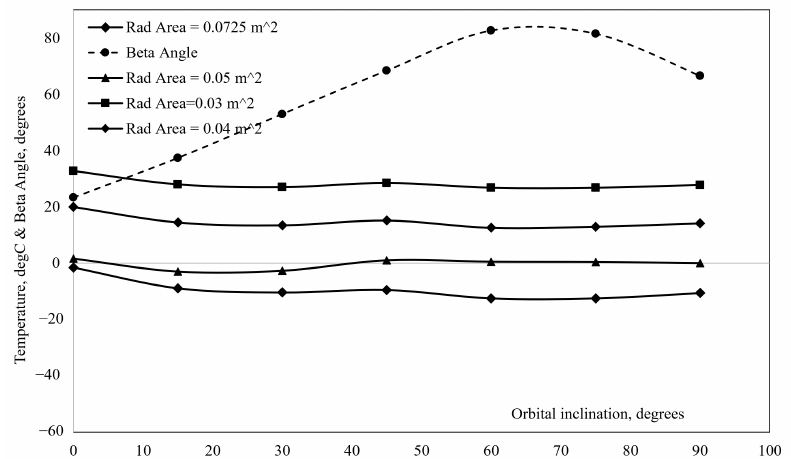
Figure 23. DR temperature variation with inclination and beta angle—Worst hot condition.